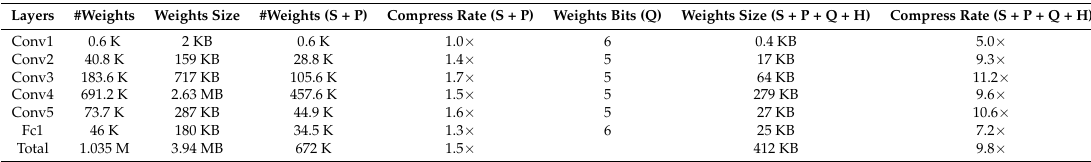
Table 6. Compression statistics in 10-class recognition experiment. S: squeezing, P: pruning, Q: quantization, H: huffman coding.